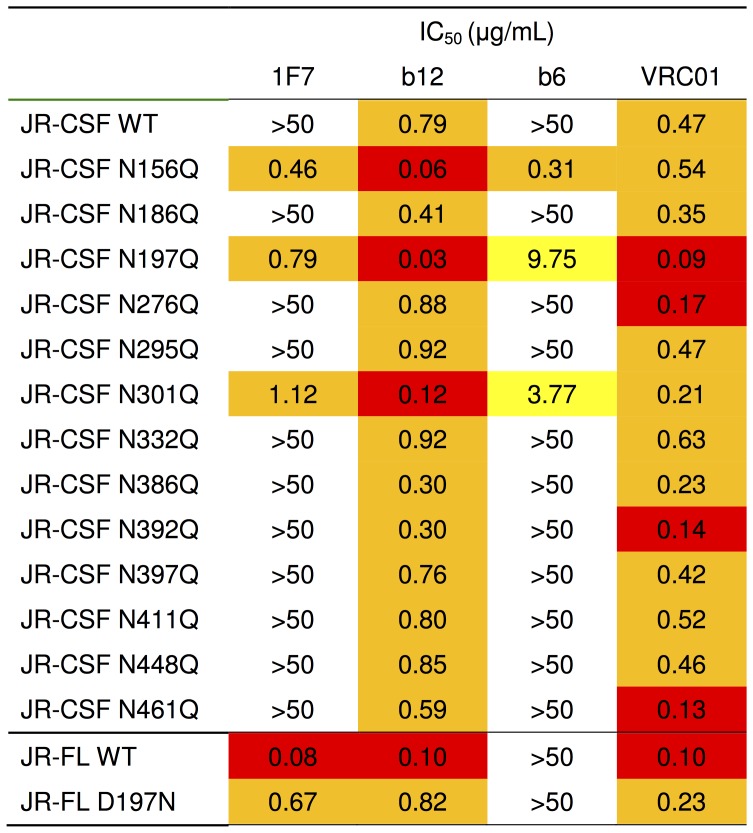
Neutralization (IC50s) of HIV-1 JR-CSF and JR-FL N-glycosylation mutants using 1F7 and other CD4bs mAbs.Neutralization assay was performed in the TZM-bl assay format. Boxes are color-coded as follows: white, median potency >50 µg/mL; green, median potency between 20 and 50 µg/mL; yellow, median potency between 2 and 20 µg/mL; orange, median potency between 0.2 and 2 µg/mL; red, median potency <0.2 µg/mL.